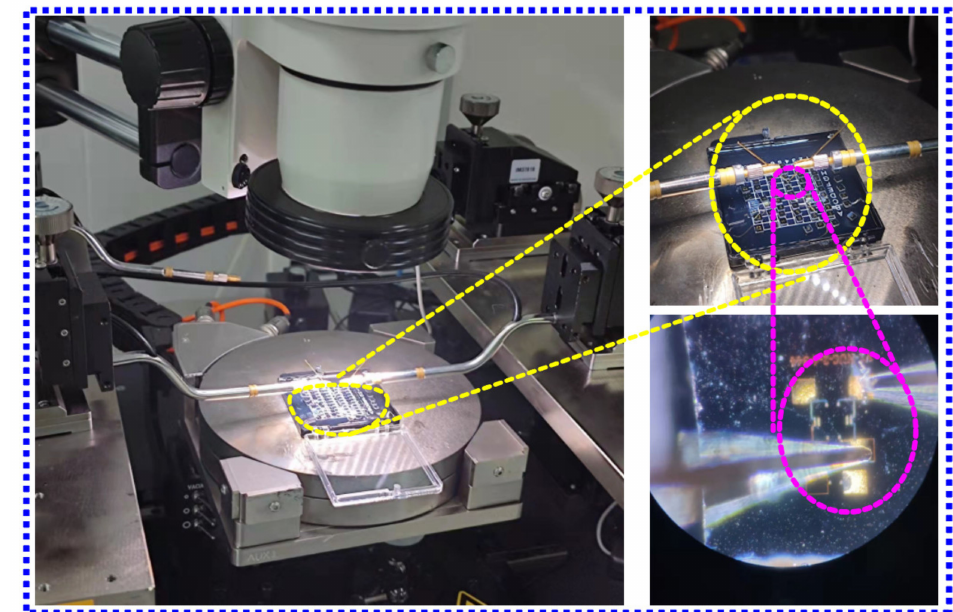
Figure 6. Diagram of semiconductor analyzer and a four-probe table.